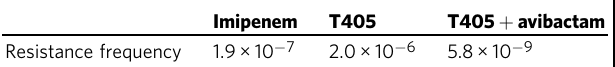
Table 2 Frequency of spontaneous resistant mutants of M. abscessus ATCC 19977 recovered against T405 and imipenem at their individual MICs and when the T405 MIC is combined with avibactam at its individual